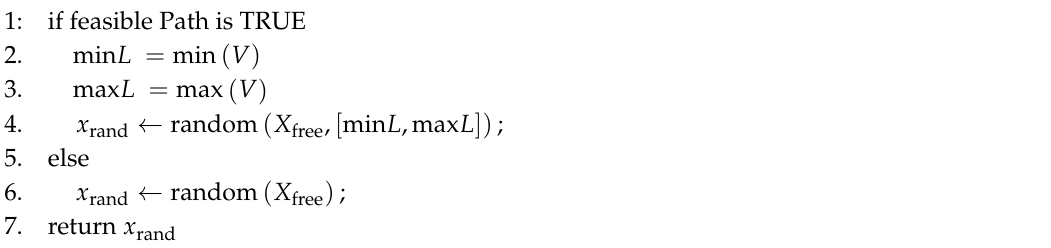
Algorithm 6: Sample ( i , feasiblePath, V , X free ) function of the RRT* Limits algorithm